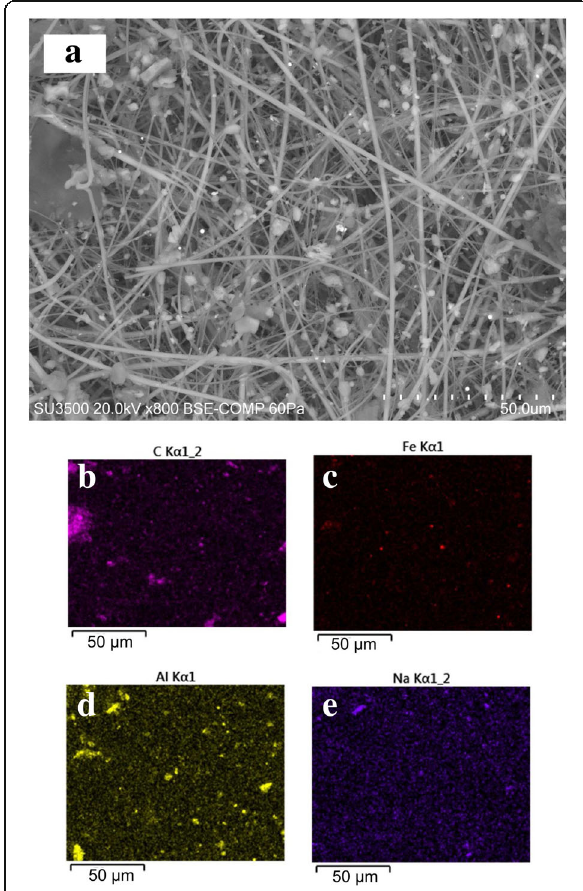
Fig. 13 The SEM and elemental mapping images of the sample filter obtained at the GD site in January 2015. a The SEM image, ( b ) the elemental map of C, ( c ) the elemental map of Fe, ( d ) the elemental map of Al, and ( e ) the elemental map of Na. Major coarse particles include Al (clay mineral) and Na (salt or